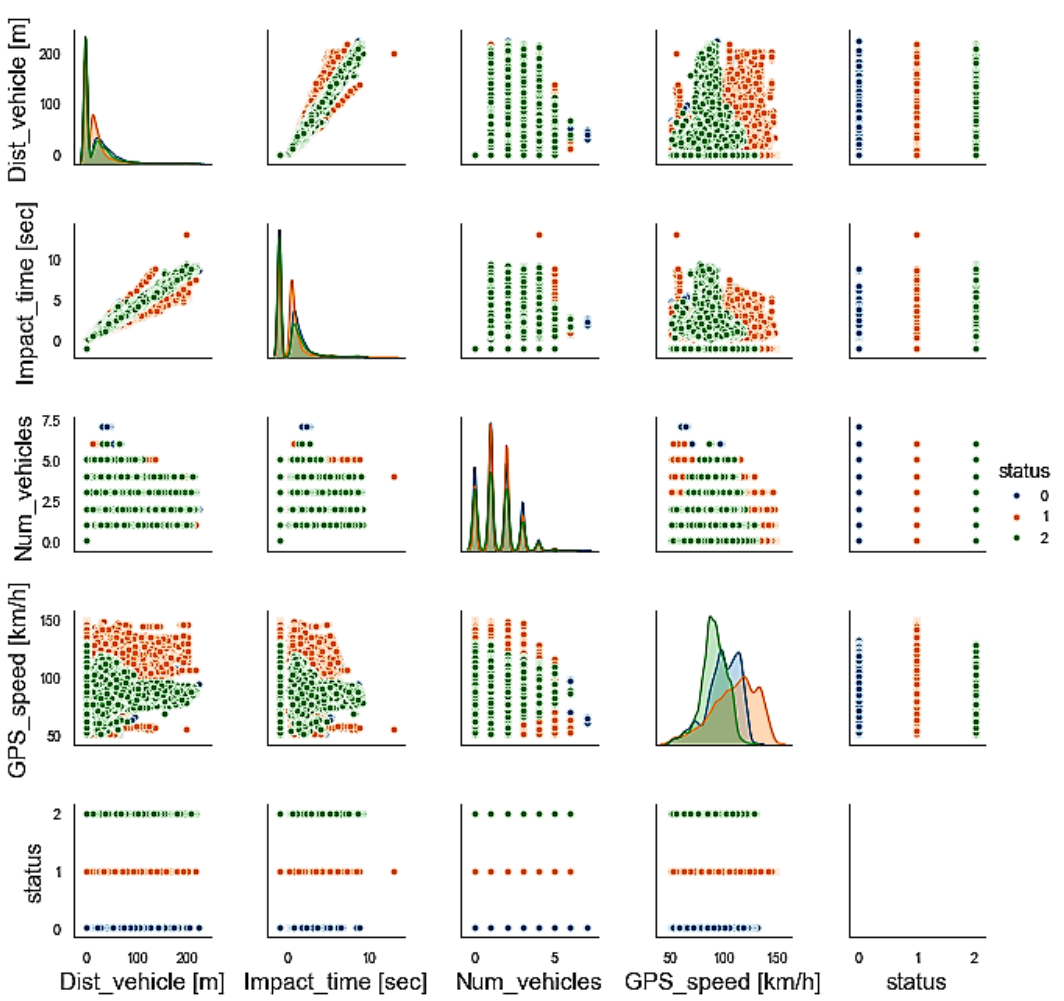
Figure 2. Feature comparison of “traffic detection”